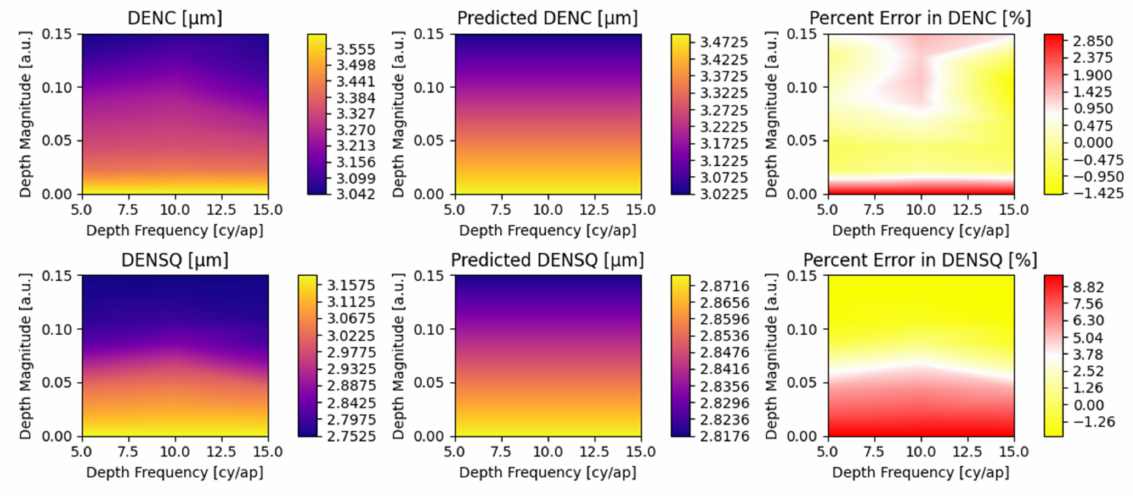
Figure A13. Depth Frequency vs. depth magnitude. ( κ = ω = δ = 0, ξ = 10, σ = 0.05, θ = 0 ◦